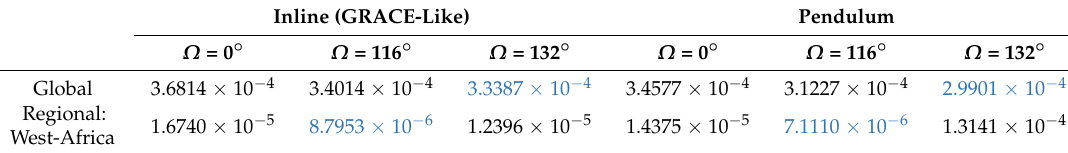
Table 7. Error RMS in terms of geoid height for global and regional (West-Africa) 6-day recovery up to L max = CNR of the scenario (a) inline and Pendulum formations. The smallest values in global and regional cases for each inline and Pendulum formation are written in blue.